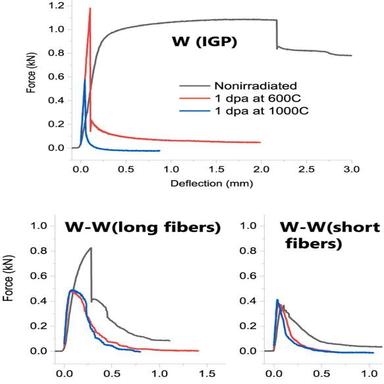
Bending tests with the KLST specimens at 600◦C for upper graph: W (IGP); lower graph: W-fiber W composites.